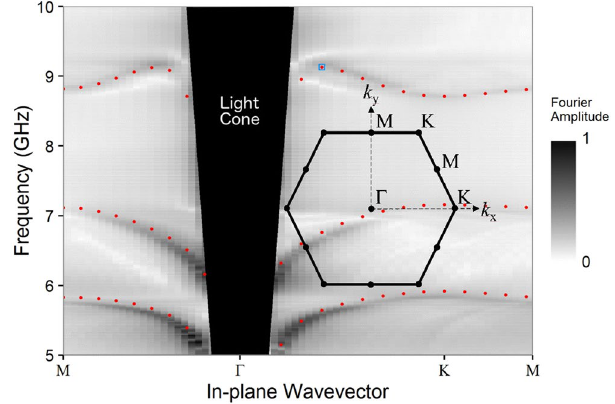
Figure 2. Fourier amplitude (arbitrary scale) of experimentally detected magnetic-field map across the spiral metasurface. This has been plotted as a function of in-plane wavevector and frequency in the first Brillouin zone (inset) to illustrate the dispersion of the supported modes. Modes within the light-line, corresponding to radiative modes, are beyond the scope of this work and have been omitted for clarity. The third-order mode has a backward wave solution as well as a positive wave solution.